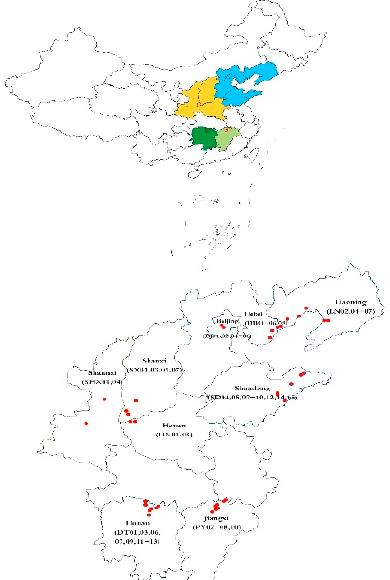
Figure 1. The geographical origins of different E. indica populations from apple orchards around Bohai Rim (Beijing, BJ; Hebei, HB; Liaoning, LN; Shandong, SD) and Loess Plateau (Henan, HN; Shanxi, SX; Shannxi, SHX) farmland around Dongting (DT) and Poyang (PY) lakes in China.